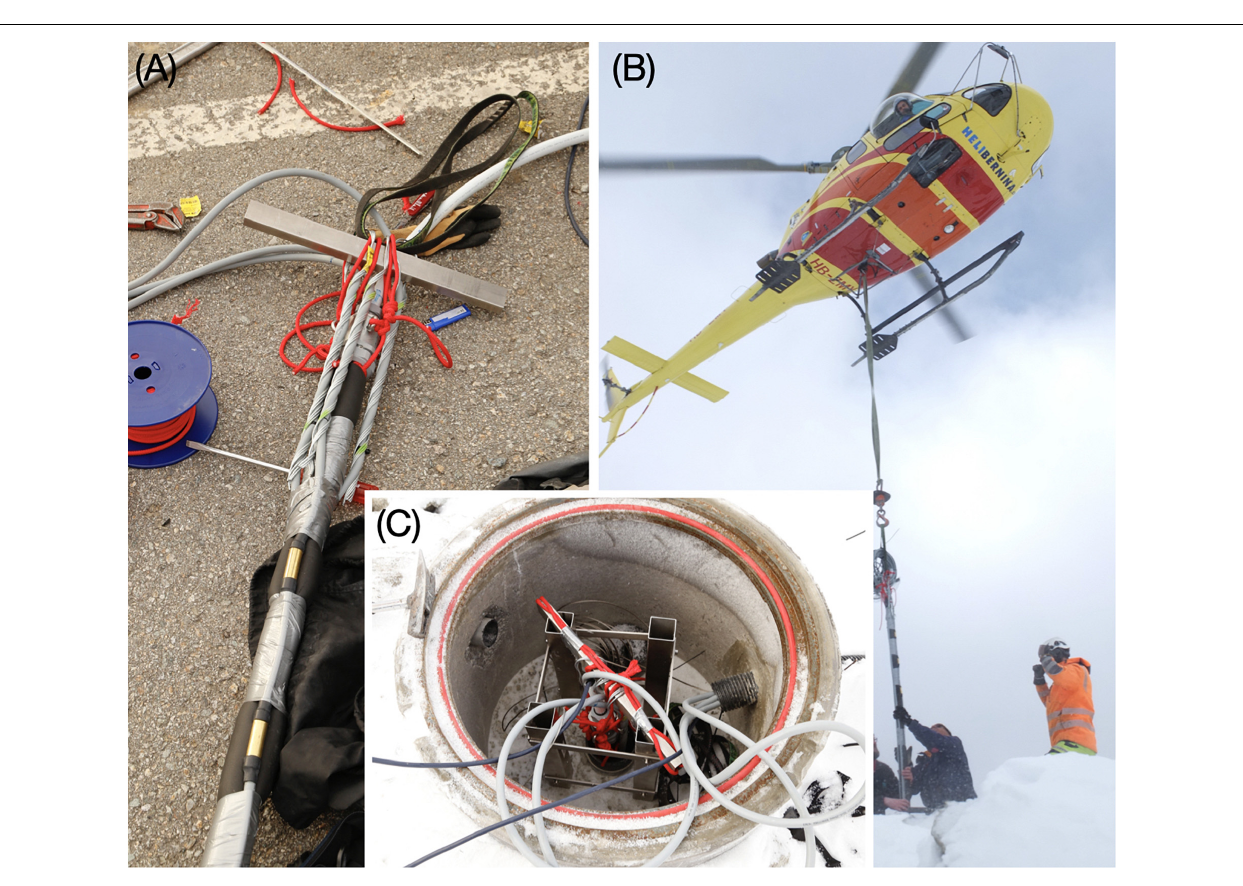
Frontiers in Earth Science |